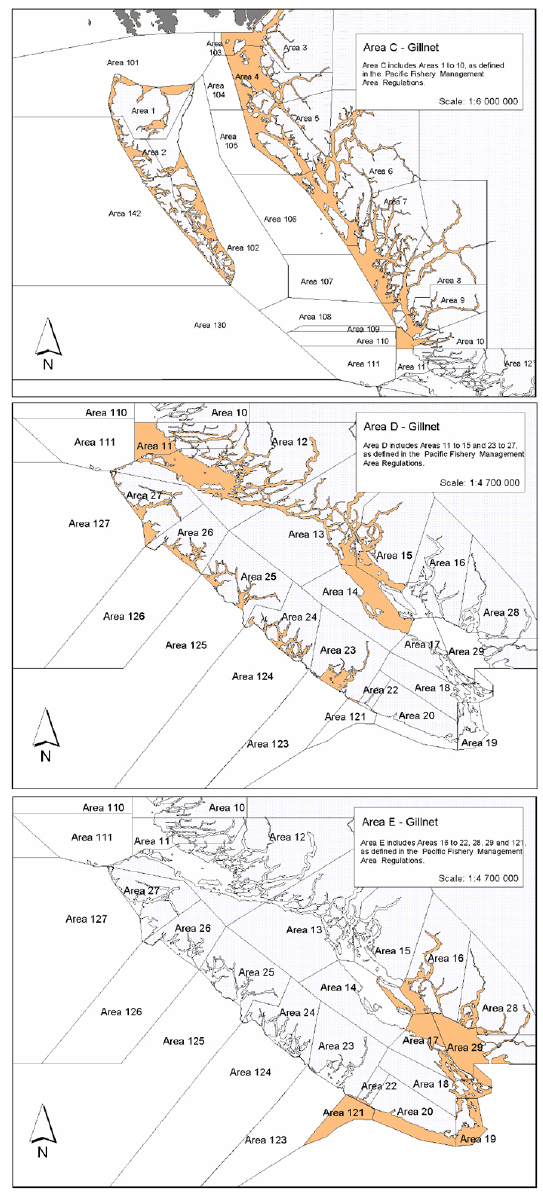
Fig. 3 . Maps of commercial salmon licence areas (C, D, and E) in British Columbia (Source: DFO